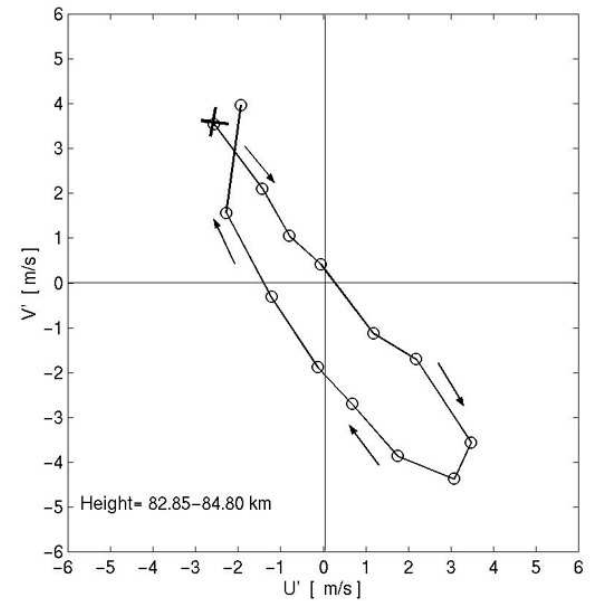
Fig. 7. Profiles of zonal (u) and meridional (v) component of wind velocity measured by ESRAD with 150-m resolution at 22:35 UT on 10 August 2000. The background wind is marked by a dashed line.